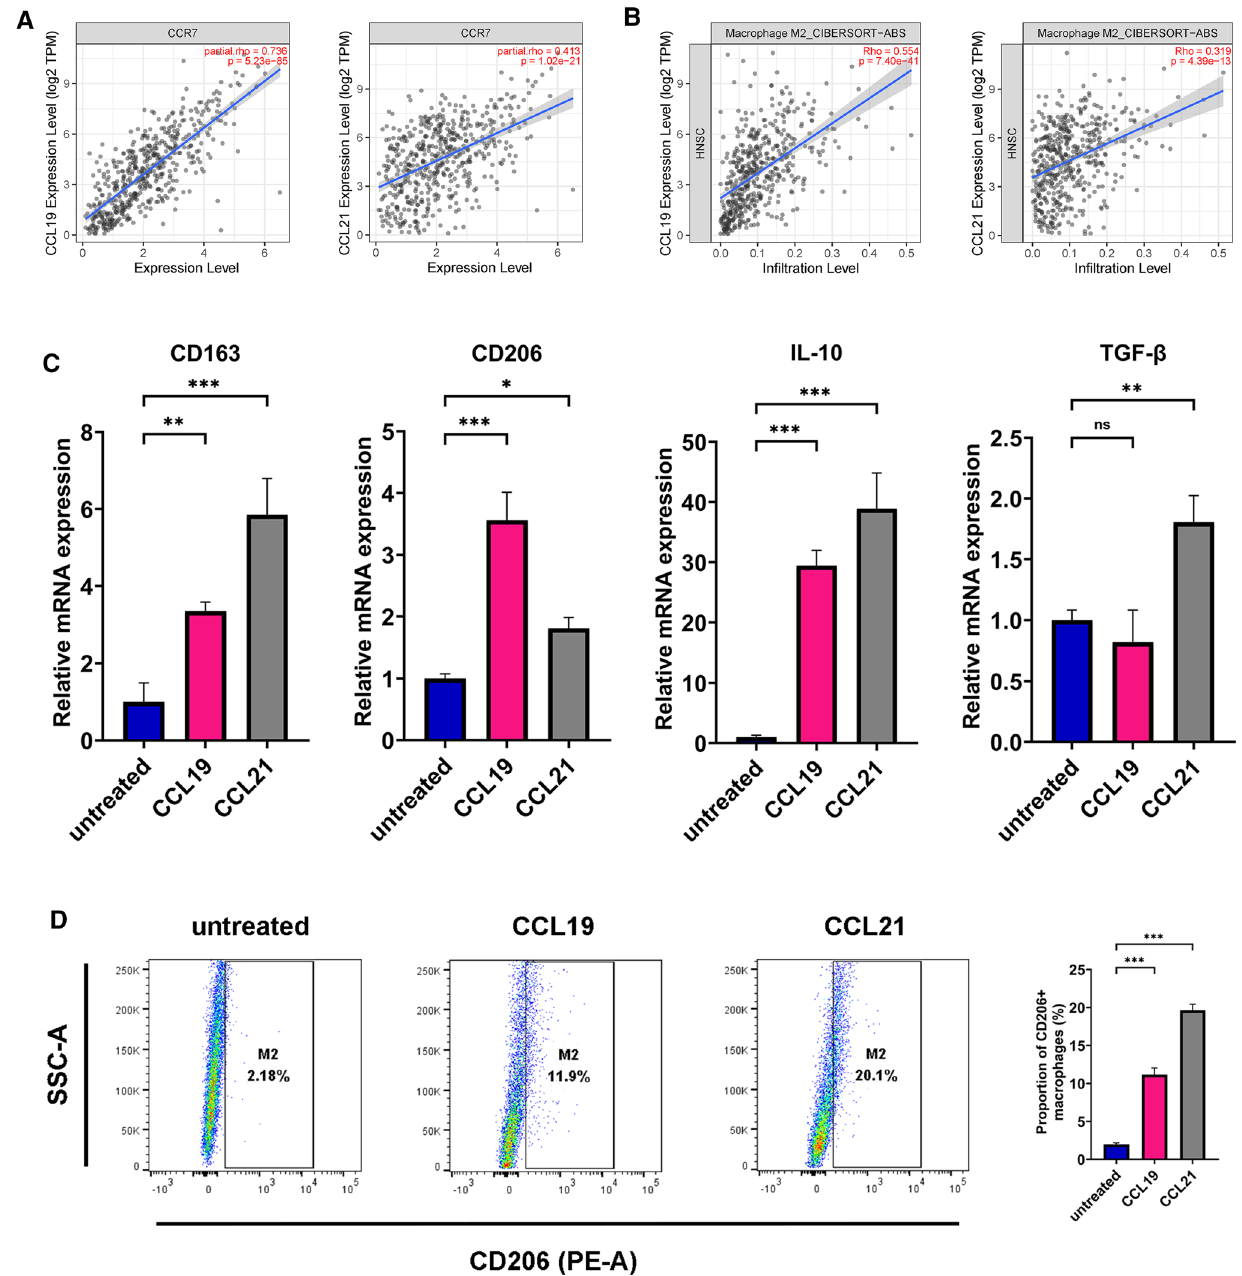
Fig. 4 CCL19 and CCL21 promoted macrophage M2-polarization in vitro. A Spearman correlation analysis of CCR7 expression with CCL19 and CCL21, based on TIMER2.0 database. B Correlation between CCR7 expression and M2 macrophage, based on TIMER2.0 database. C The mRNA expression level of CD163, CD206, IL-10 and TGF-β1 of THP-1 derived macrophages stimulated by 400 ng/ml recombinant human CCL19 and CCL21, evaluated by qRT-PCR. D Representative Scatter plots showed the CD206 expression level of macrophages incubated with 400 ng/ml recombinant human CCL19 and CCL21, measured by flow cytometry. The histogram displayed statistical analysis for the pro- portion of CD206+ macrophages. The results are presented as the mean ± SD, * P < 0.05, ** P < 0.01, *** P <